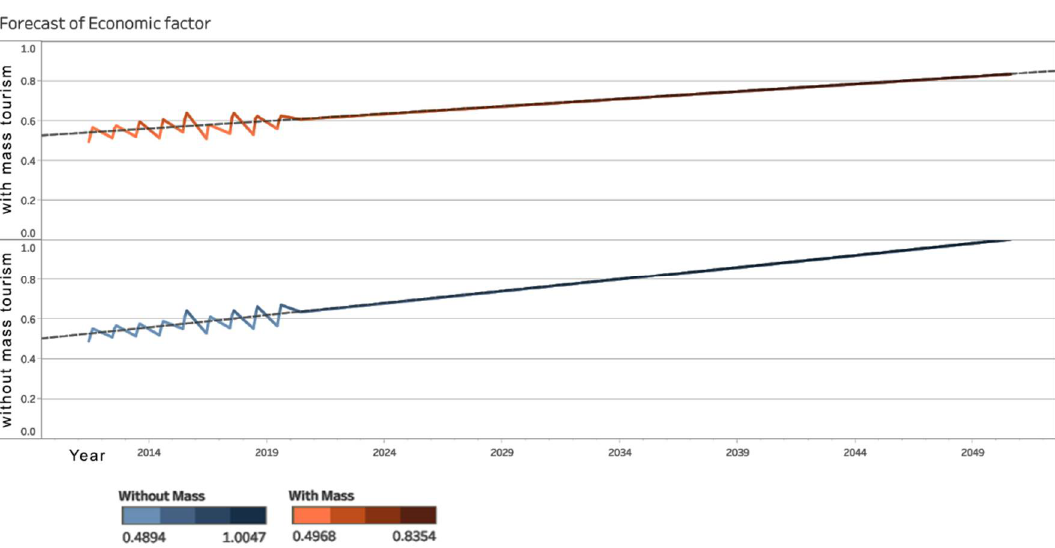
Figure 12. Economic factor forecast by 2050.